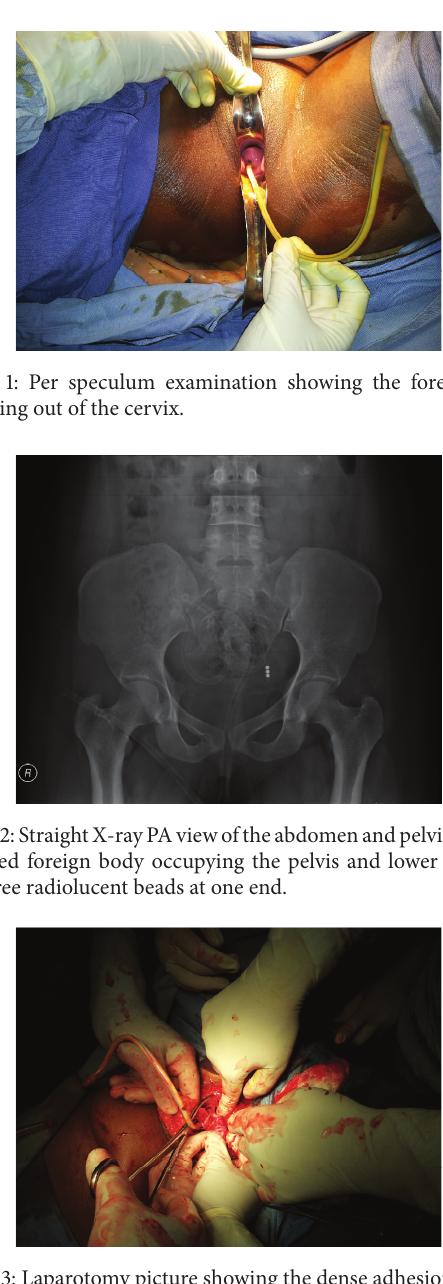
Figure 3: Laparotomy picture showing the dense adhesion of loops of bowel and omentum to the foreign body.